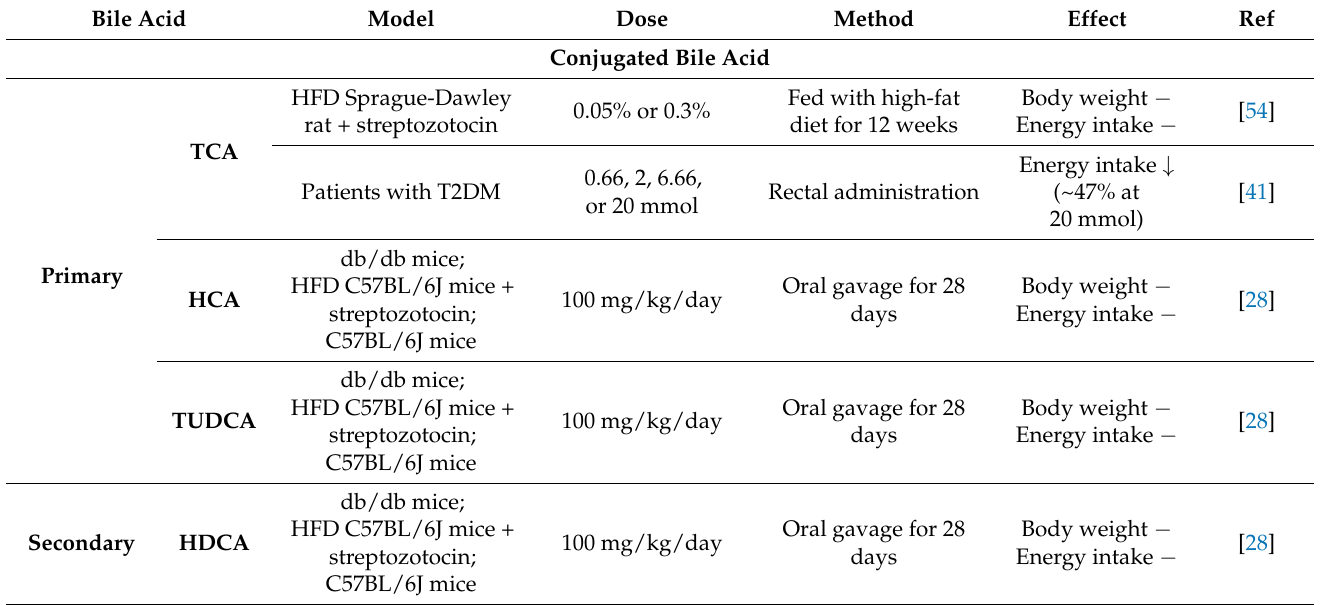
Table 2. Reported effects of bile acids on energy intake and body weight in preclinical and clinical